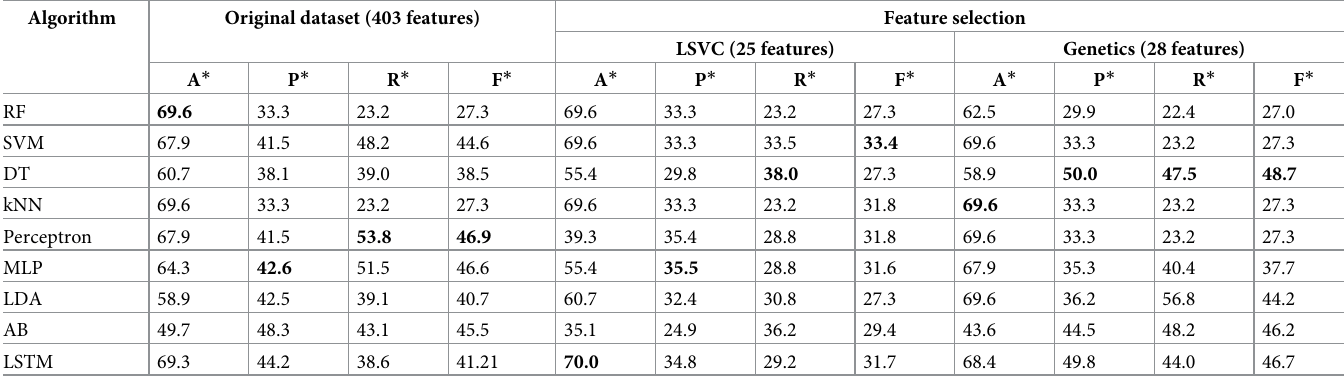
Table 2. Comparison of the results of the algorithms on the initial dataset and the ones with feature selection approach without data augmentation (no. class = 3). Algorithm Original dataset (403 features)